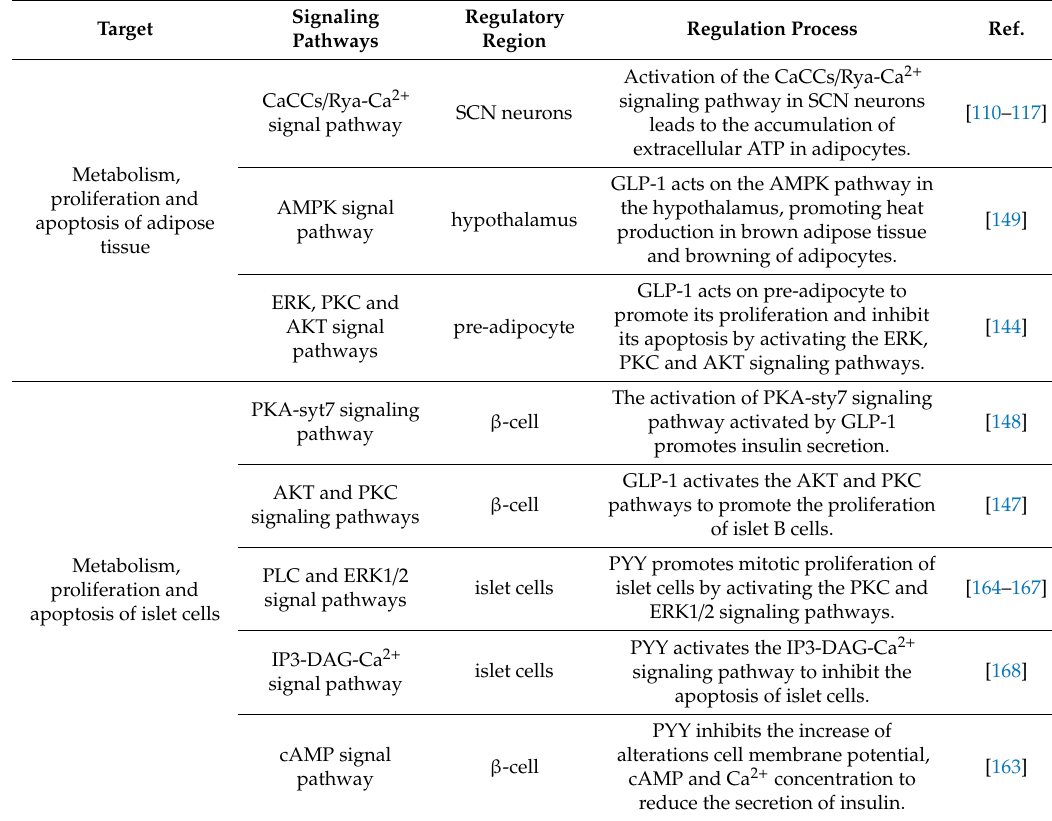
Table 3. The summary of the main calcium signaling pathways involved in the regulation of obesity by the biological clock and the intestinal